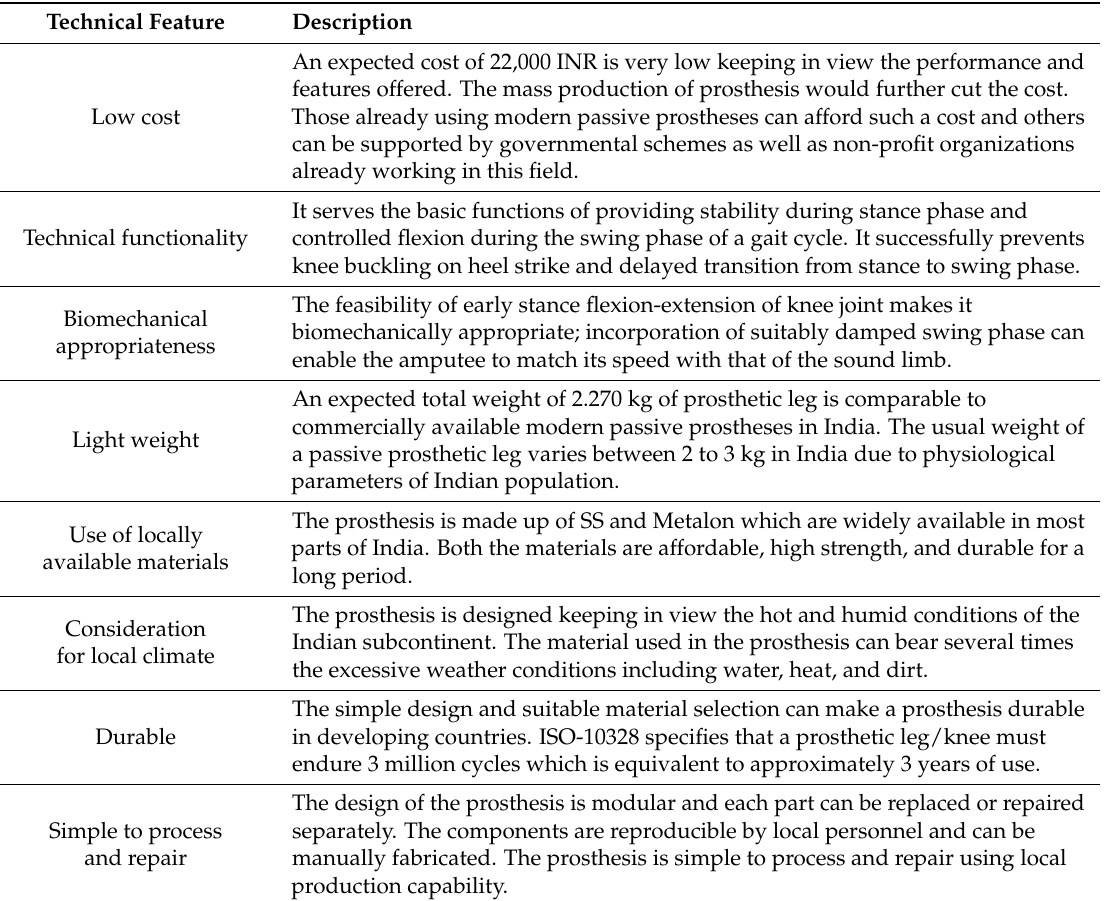
Table 6. Technical features and descriptions based on recommendations of ISPO consensus conference on appropriate prosthetic technology in developing countries